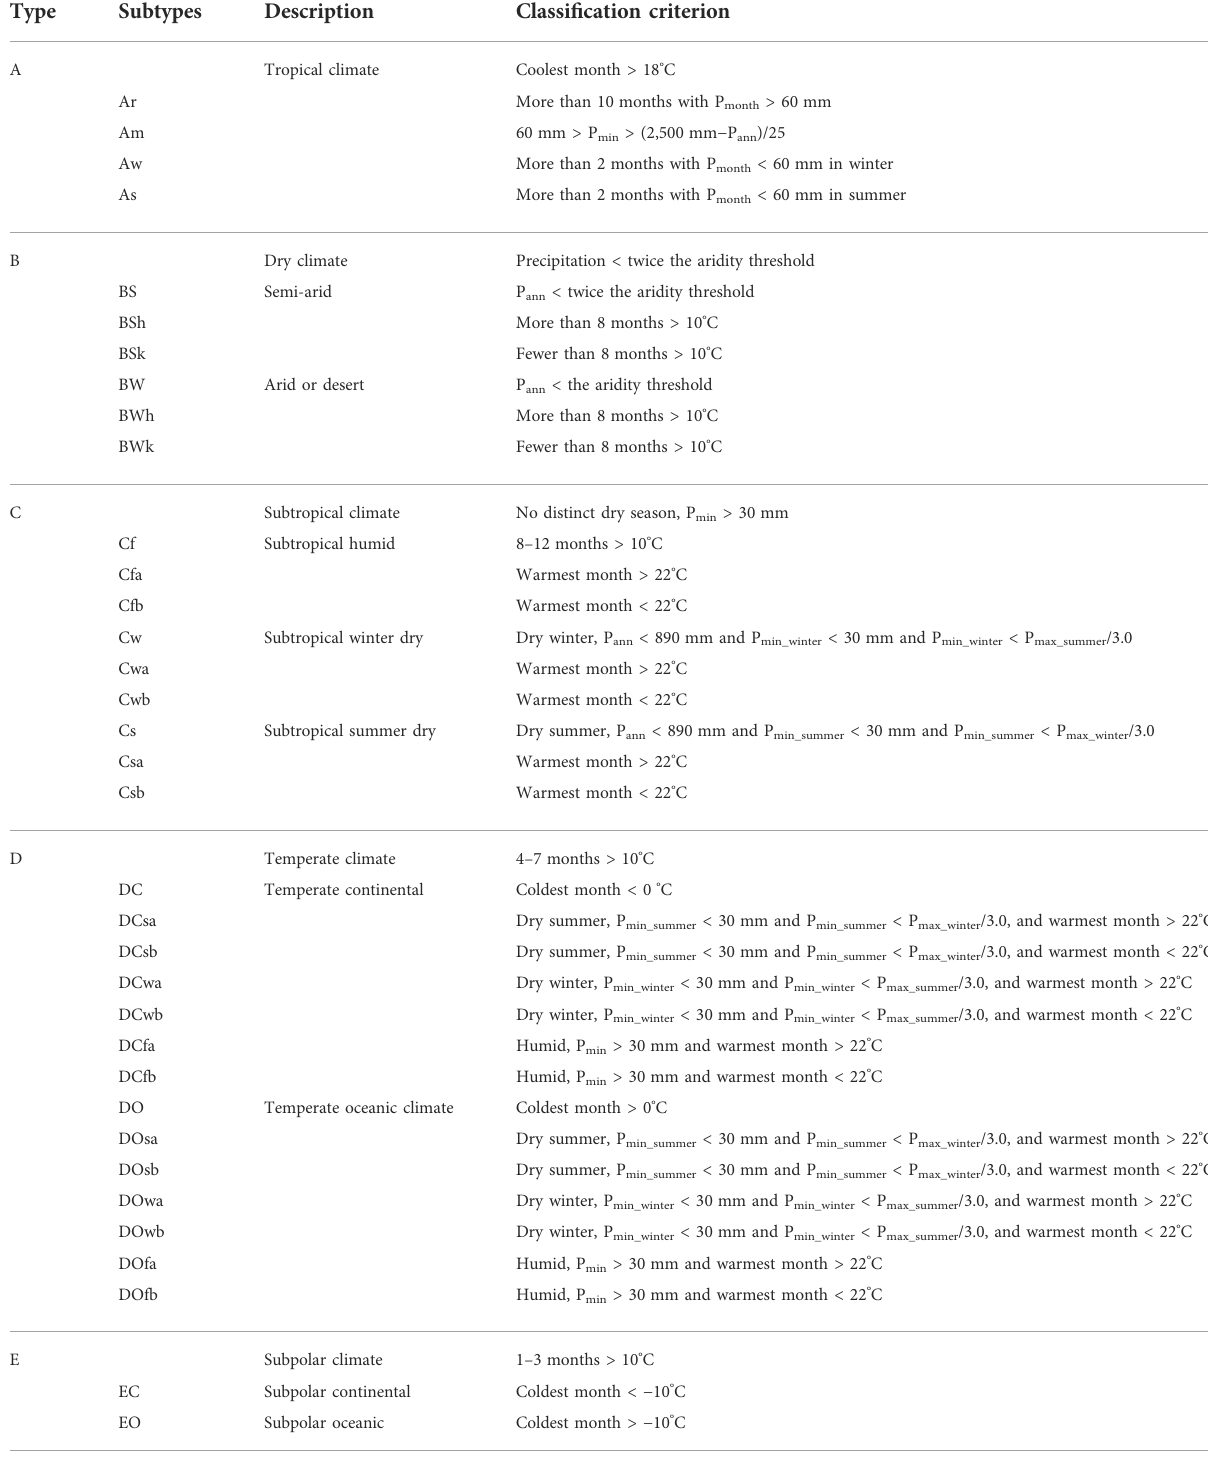
TABLE 1 The criteria used for the Köppen-Trewartha climate classi fi cation system. P month and P ann are the monthly and annual precipitation (units: mm), respectively. P min , P min_winter , and P min_summer are the months with minimum precipitation (units: mm) during the winter and summer seasons.P max ,P max_winter ,andP max_summer arethemonthswithmaximumprecipitation(units:mm)duringthewinterandsummerseasons.Thearidity thresholdisde fi nedas10×(T ann – 10)+3P,T ann istheaverageannualtemperature(units: °